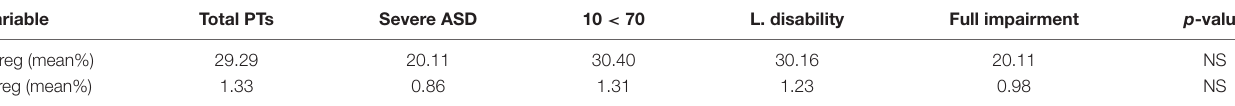
TABLE 3 | B and T regulatory subsets means: comparison between total PTs and sub- groups of severity. Variable